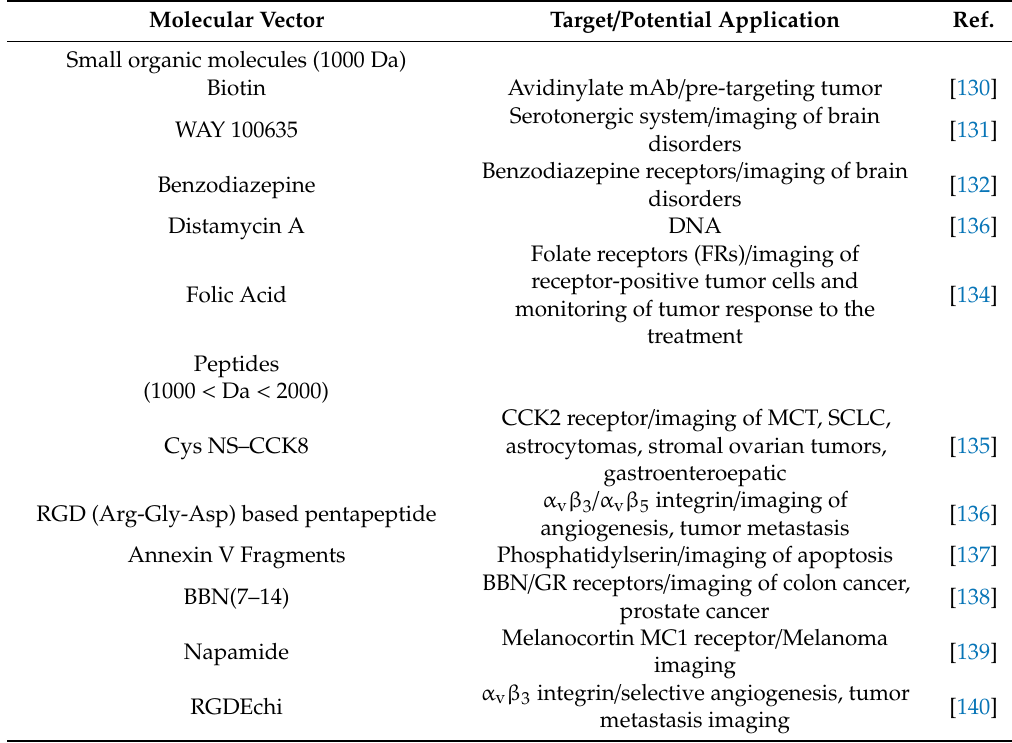
Table 5. Targeting vectors labeled with [ 99m Tc][TcN(PNP)] 2 + building